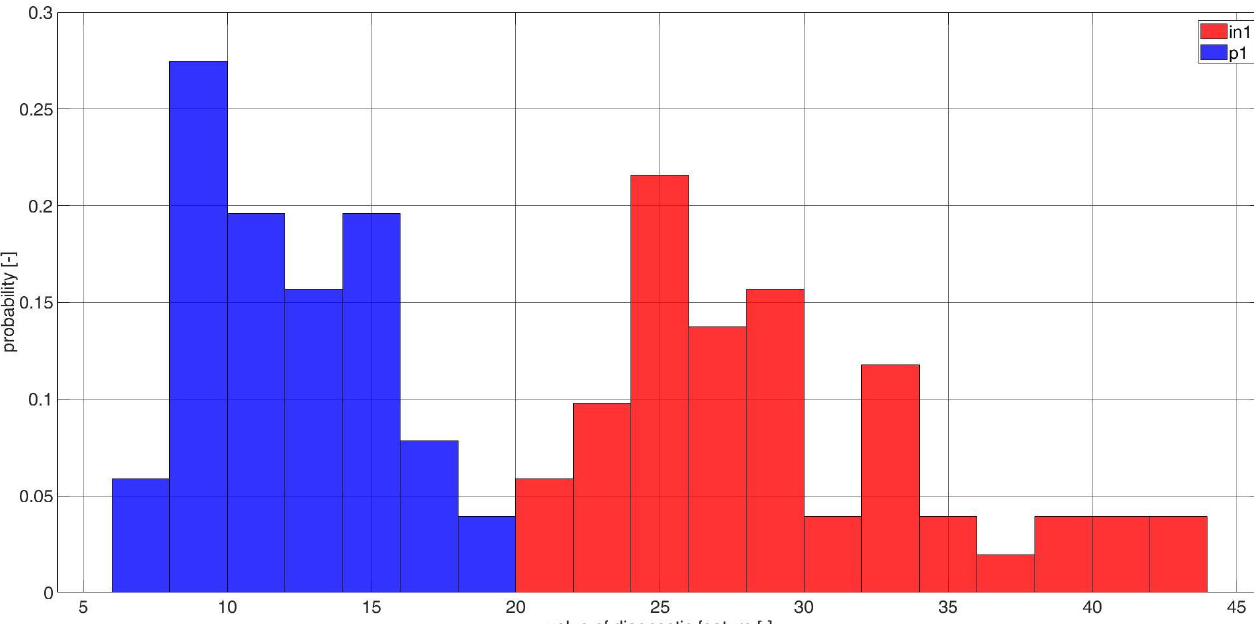
Figure A2. Histograms of diagnostic features based on the CCSM3 (correlation number is 4 — Table A1) bearings in2 and p2.